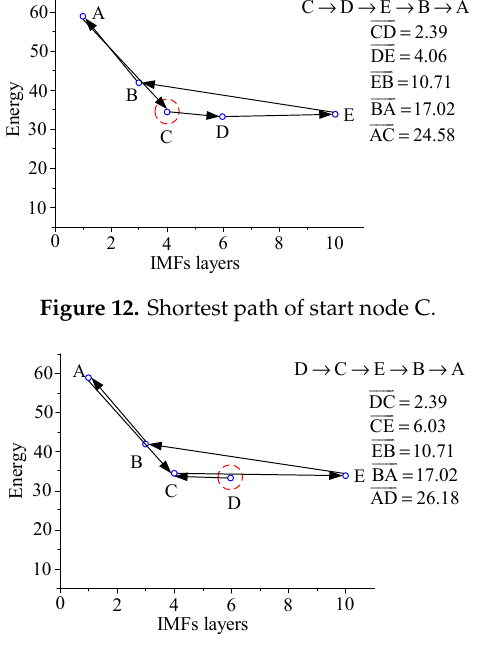
Figure 13. Shortest path of start node D.